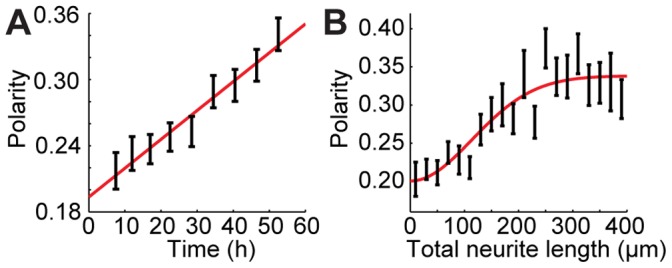
Dynamics of neuron polarization as defined by Eq. (1).
A, Polarity versus time. The solid line is a linear fit to the data. B, Polarity versus total neurite length. Total neurite length was binned at intervals of 20 µm. The solid line is a Gaussian fit to the data, with an inflection point at 114 µm suggesting a phase transition between unpolarized and polarized states. The nonlinearity of this data agrees with previous work on the polarization of neurons with exactly two neurites [19].